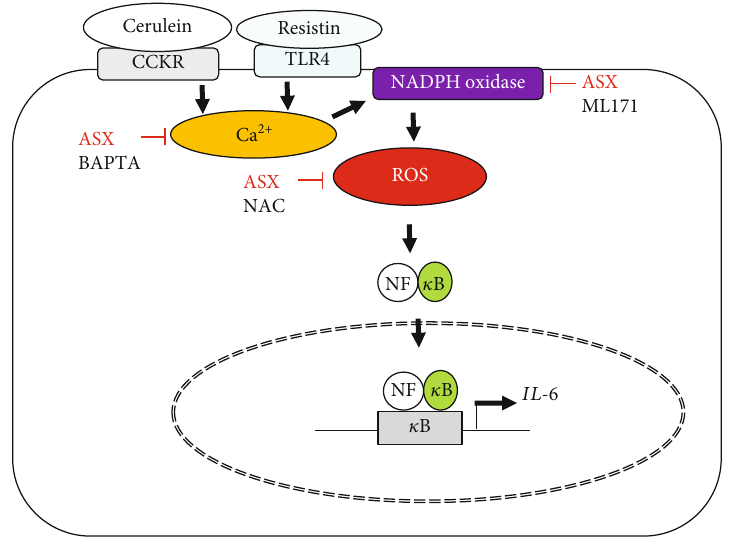
Figure 8: The proposed mechanism by which astaxanthin (ASX) inhibits interleukin-6 (IL-6) expression in cerulein/resistin-stimulated pancreatic acinar cells. Binding of cerulein to cholecystokinin receptor (CCKR) increases intracellular Ca 2+ level while binding of resistin to Toll-like receptor 4 (TLR4) initiates Ca 2+ overload. High level of Ca 2+ activates NADPH oxidase to produce reactive oxygen species (ROS). ROS induce NF- κ B activation and the expression of IL-6 in pancreatic acinar AR42J cells. ASX reduces Ca 2+ overload and inhibits NADPH oxidase-mediated ROS production, NF- κ B activation, and IL-6 expression. The calcium chelator BAPTA-AM, an antioxidant N- acetyl cysteine (NAC), and ML171, a speci fi c NADPH oxidase 1 inhibitor, suppress cerulein/resistin-induced ROS production, NF- κ B activation, and IL-6 expression in AR42J